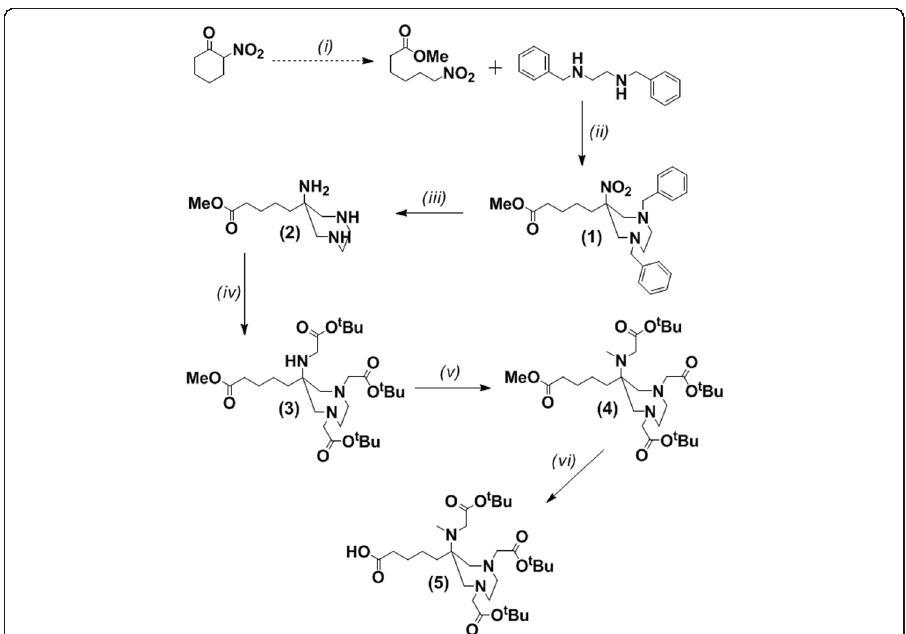
Fig. 2 Synthesis of the unconjugated DATA prochelator - DATA M5 -3 t Bu. (i) Amberlyst-21, EtOH; (ii) CH 2 O, EtOH; (iii) CH 3 COOH, Pd(OH) 2 /C, H 2 , EtOH; (iv) BrCH 2 COO t Bu, K 2 CO 3 , MeCN; (v) CH 3 I, K 2 CO 3 , DCM : MeCN; (vi) LiOH, THF :